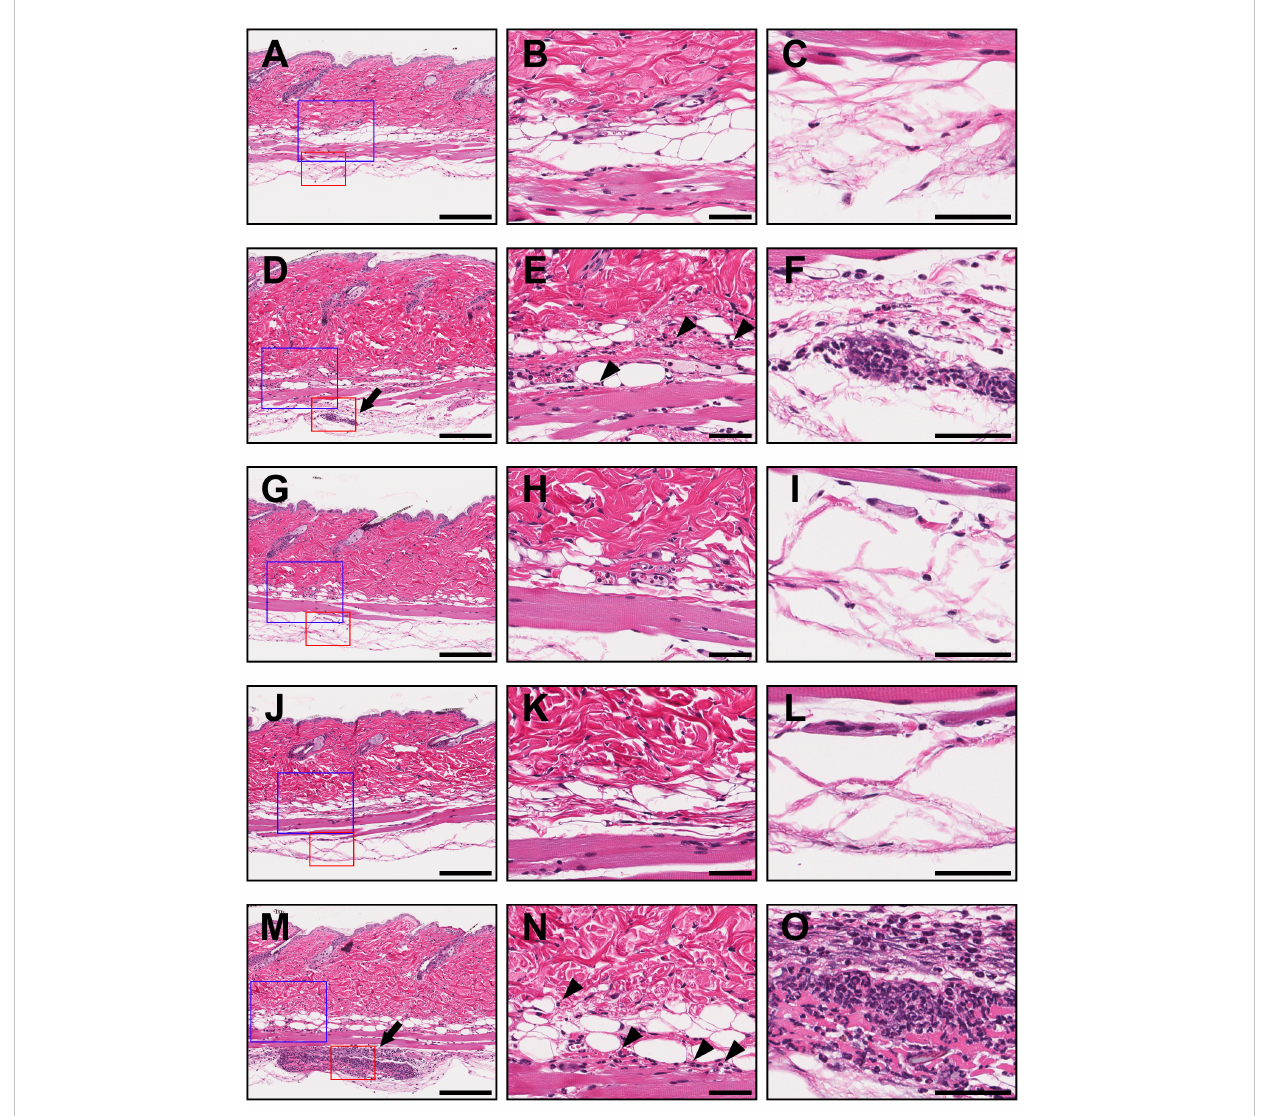
FIGURE 5 Histopathological examination of injection sites in a mouse model of IC-induced subcutaneous in fl ammation. The skin biopsy specimens collected from injected areas of PBS (A – C) , TNF a (D – F) , ozoralizumab-TNF a IC1 (G – I) , ozoralizumab-TNF a IC2 (J – L) , and adalimumab-TNF a ICs (M – O) were examined histopathologically after hematoxylin and eosin staining. The center column and right column are high magni fi cation views of the blue boxes and red boxes, respectively, in the left column. The arrows point to focal neutrophil in fi ltration in the deeper layer of the